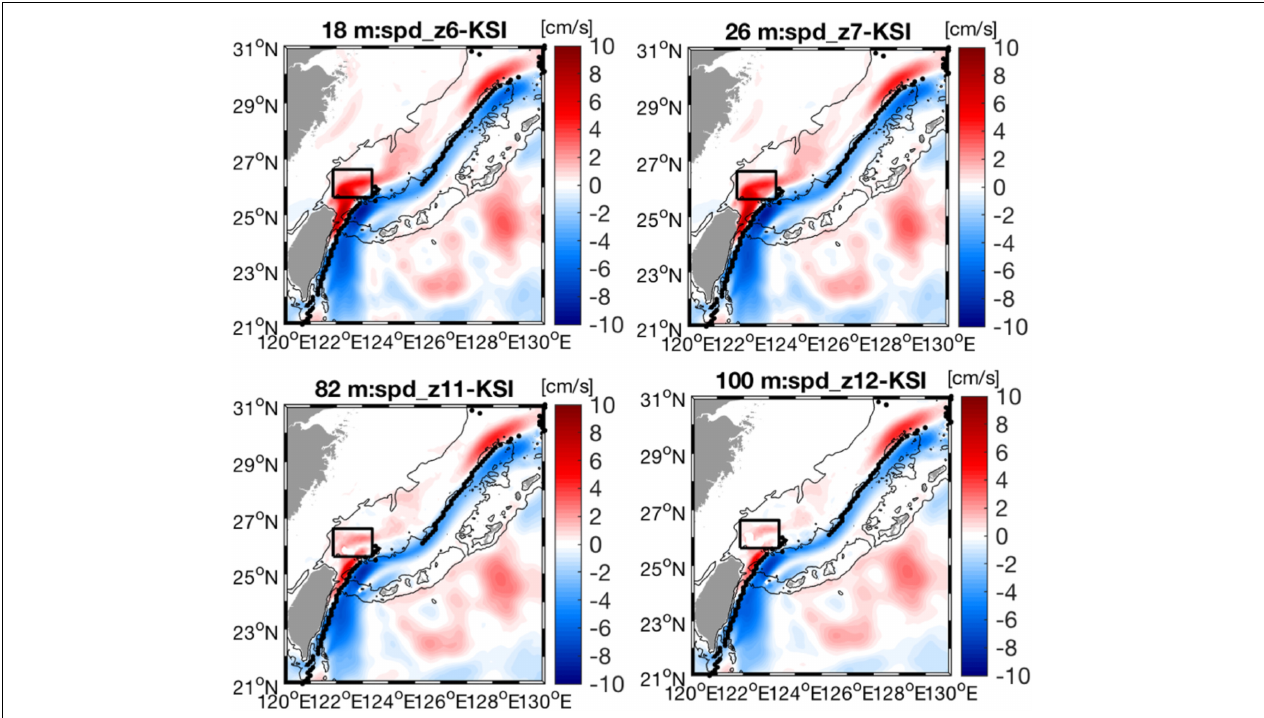
FIGURE 5 | Regressed subsurface current speed anomalies at 18, 26, 82, 100 m, targeting the KSI strength mode from FORA. The mean path of the Kuroshio is displayed as black dots. Black squares denote the KSI domain, and the black contours denote 100 and 1,000 m isobaths.